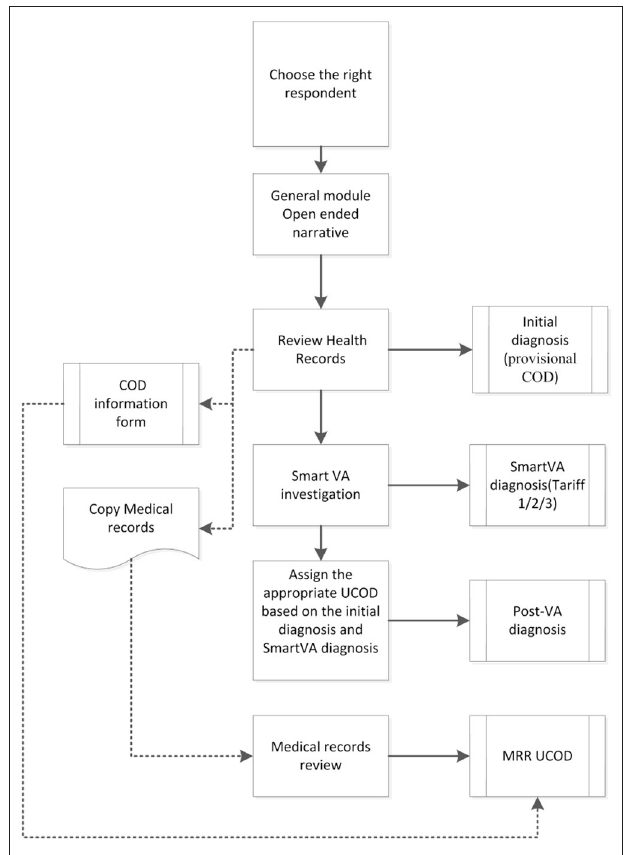
FIGURE 1 | The field implementation procedures for this study.